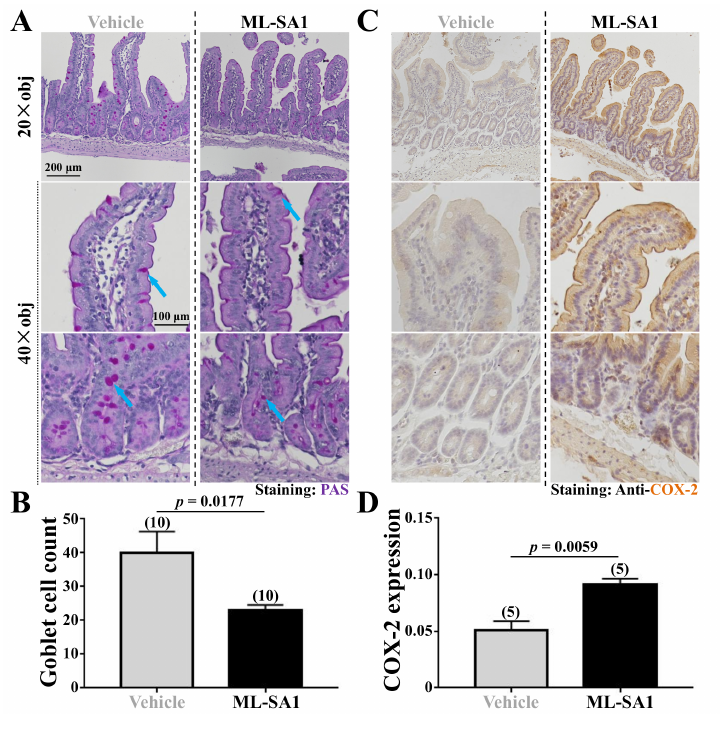
Figure 3. ML-SA1 treatment decreased the amount of goblet cells and induced inflammation in duodenum of mice. (A) PAS staining of duodenum sections from the vehicle-treated or ML-SA1-treated mice. Blue arrow, goblet cells that stained heavier. Scale bar, 200 μm for the 20× objective lens and 100 μm for the 40× objective lens. (B) Summary of (A). Numbers in the brackets indicated the number of sections from mice used. Data were presented as mean ± SEM. (C) Immuno-histochemical staining of duodenum sections from the vehicle-treated or ML-SA1-treated mice. Scale bar, the same as (A). (D) Summary of (C). Numbers in the brackets indicated the number of sections from mice used. Data were presented as mean ±